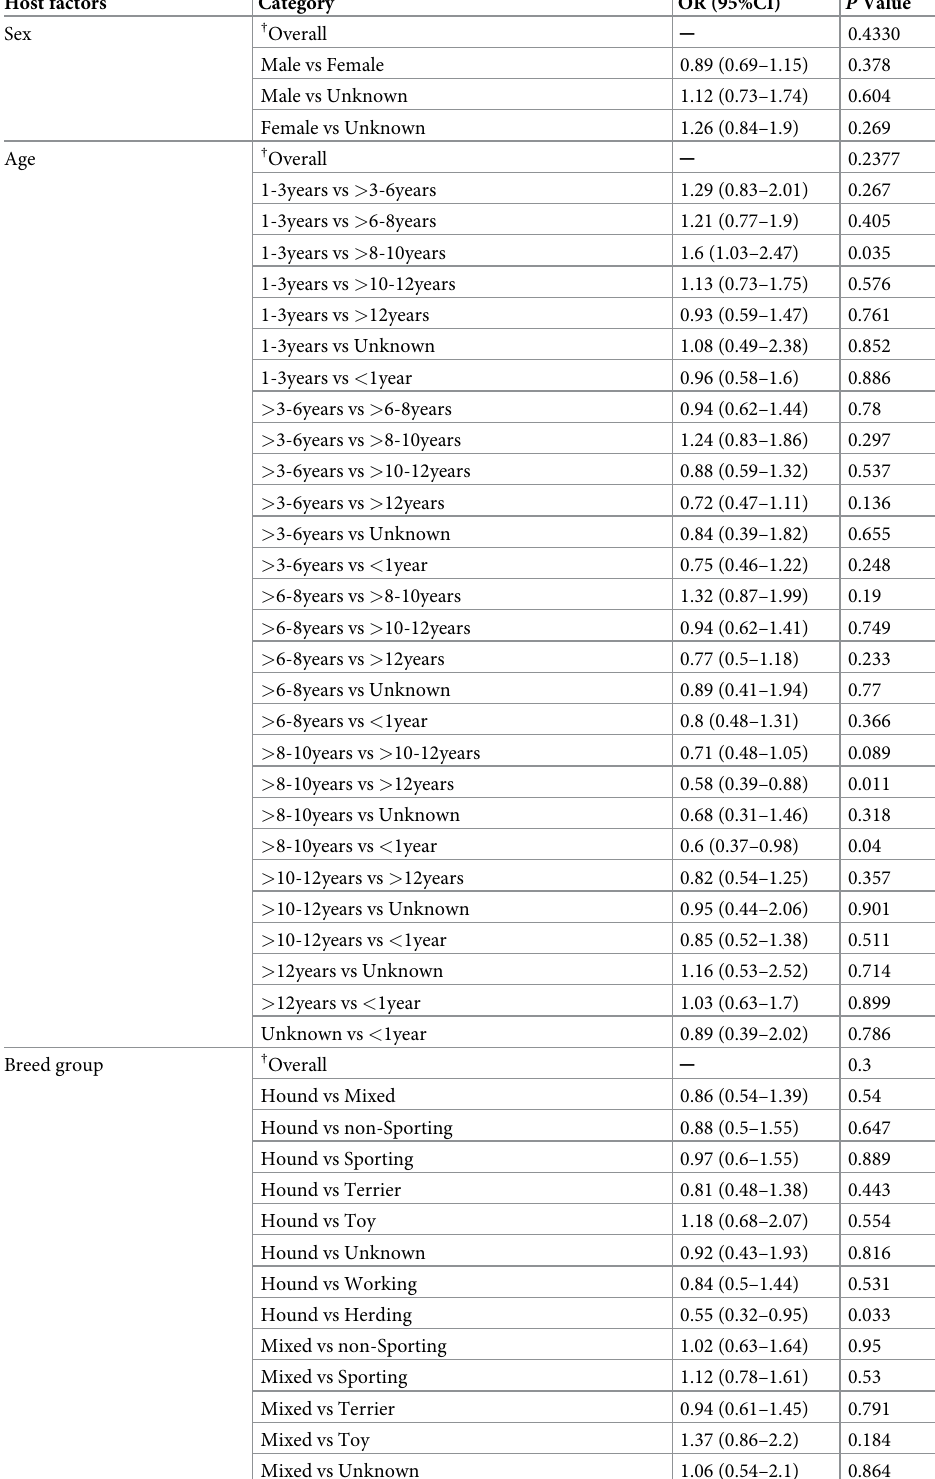
Table 6. Results of univariable logistic regression models assessing the association of host factors with multi-drug resistance among Escherichia coli isolated from dog specimens originating from